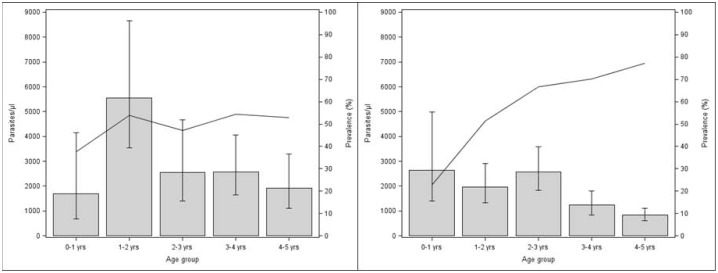
Prevalence of parasitemia and geometric mean parasite densities according to the season.a. Age-specific prevalence of parasitemia and geometric mean parasite densities in the high transmission season. Line indicates parasitemia prevalence. Bars indicate geometric parasite density and 95% confidence interval. b. Age-specific prevalence of parasitemia and geometric mean parasite densities in the low transmission season. Line indicates parasitemia prevalence. Bars indicate geometric parasite density and 95% confidence interval.